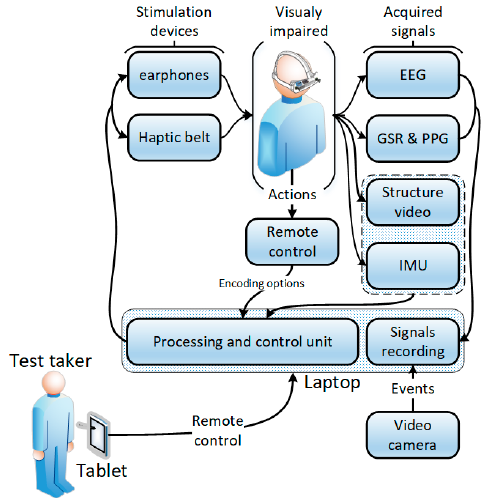
Figure 2. The system architecture for the real-world (RW) setup. PPG-plethysmography.